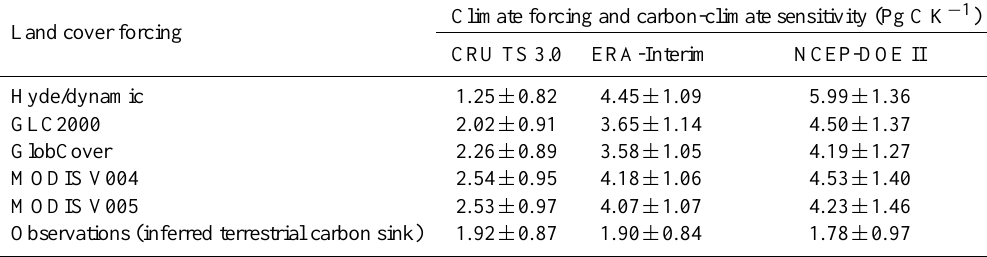
Table 5. Sensitivity of global annual net ecosystem exchange fluxes (NEE) to temperature anomalies for 1989–2005 ( p < 0 . 1 for all land cover and climate forcing combinations, except for the dynamic vegetation and CRU combination=0.15).